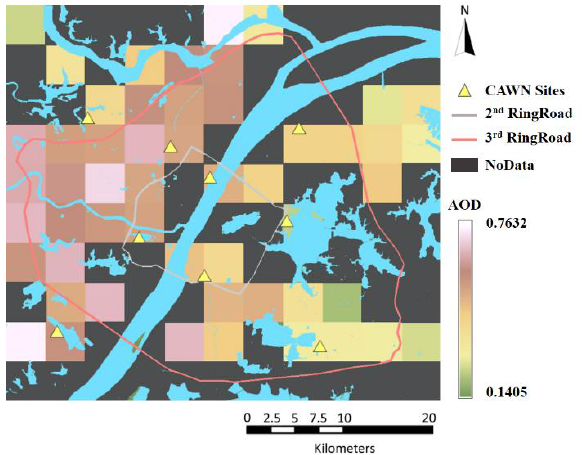
Figure 2. MOD04_3K data on February 17 th 2017 of Wuhan In this study, NDVI, MNDWI, NDBI and Albedo retrieved form Landsat-8 with 30 meters resolution are resampled into 120 meters resolution, which is optimized by semi-variogram. Then surface-level PM2.5 concentration with 120 meters resolution is obtained by STCK (Figure 3). The accuracy assessment of STCK reveals that the Root Mean Square Error (RMSE) of STCK is 2.482, reduction of RMSE (RRMSE) compared with CoKriging (CK) is 19.72%. In other words, the accuracy of spatial-temporal interpolation conducted by STCK is 19.72% higher than conducted by CK.